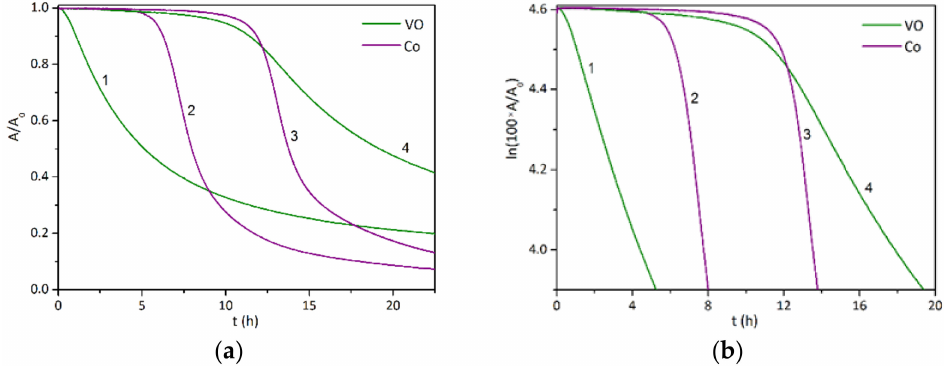
Figure 4. Time-dependent integral plots of the [ ν a ( cis –C= C – H )] in alkyd films: ( a ) In linear scale; ( b ) In logarithmic scale. Following formulations were studied: (1) 0.03 wt % VO/S401; (2) 0.03 wt % Co/S401; (3) 0.03 wt % Co/S471; (4) 0.03 wt % VO/S471.